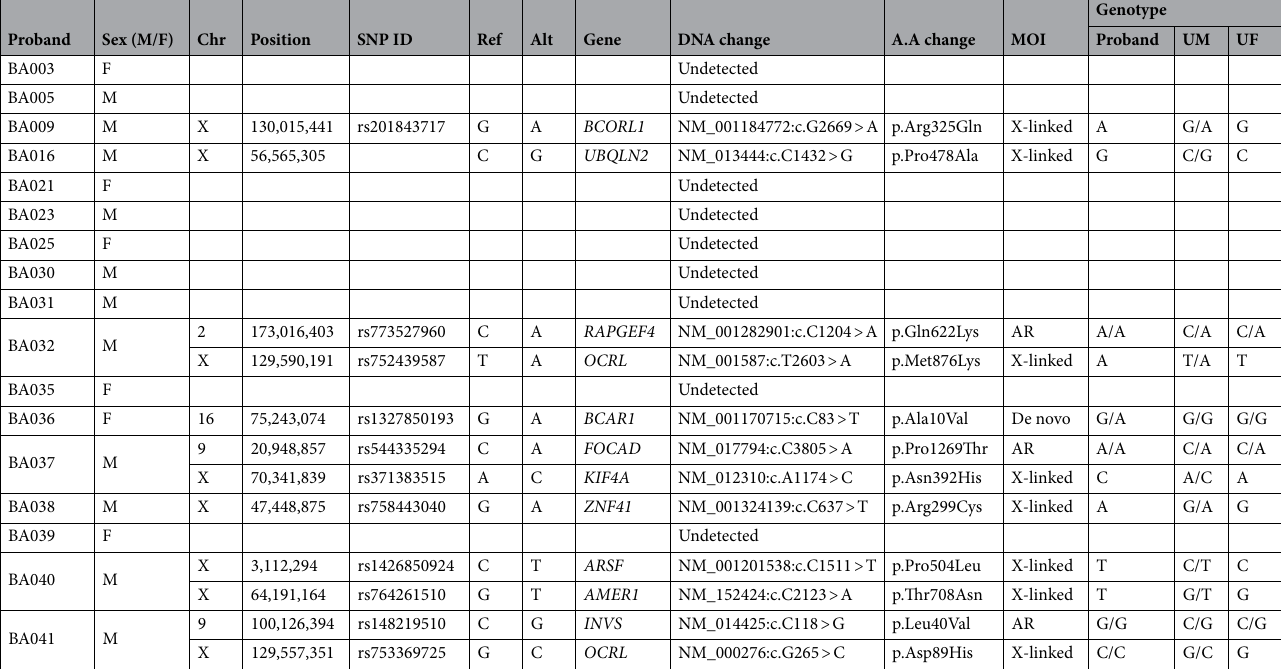
Table 3. Identical variants detected from blood and liver samples. Chr chromosome, M male, F female, Ref reference, Alt alternative, A.A amino acid, MOI mode of inheritance, AR autosomal recessive, UM unaffected mother, UF unaffected